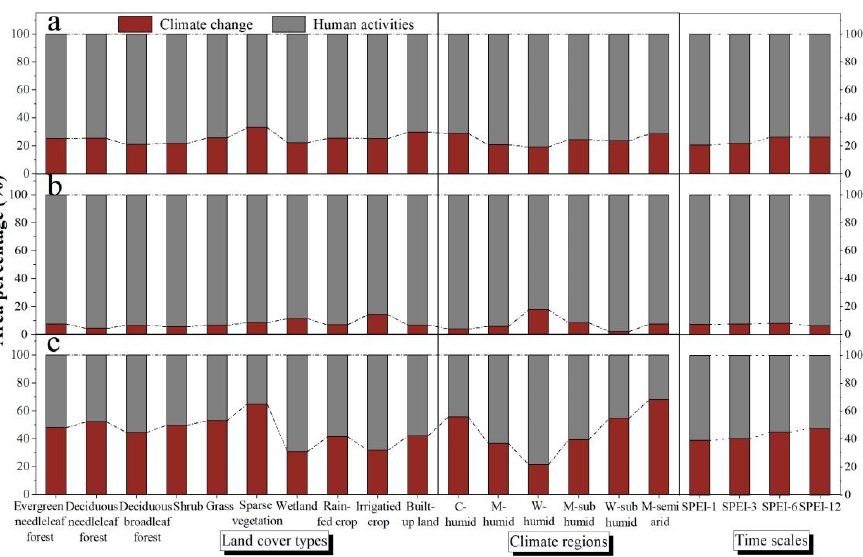
Figure 8. The relative proportions and roles of climate change and human activities on areas with observed NDVI ( NDVI obs ) changes ( a ), NDVI obs increasing ( b ), and NDVI obs decreasing ( c ) in different land cover types and time scales (i.e., the area corresponding to the time scale with the largest absolute value of the correlation coefficient between NDVI and multi time scales SPEI.